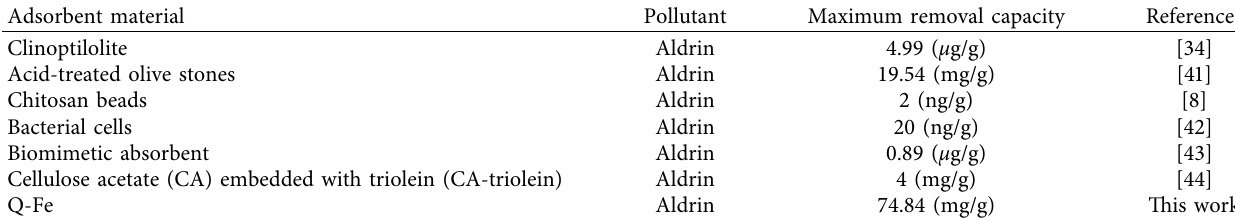
Table 4: Works with chitosan and/or iron